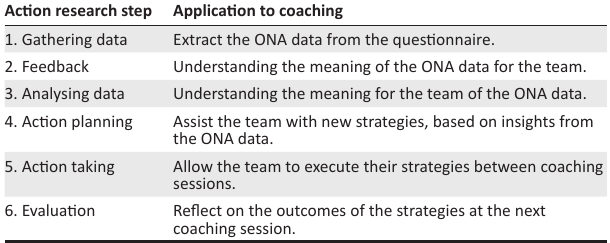
TABLE 1: Action research steps and